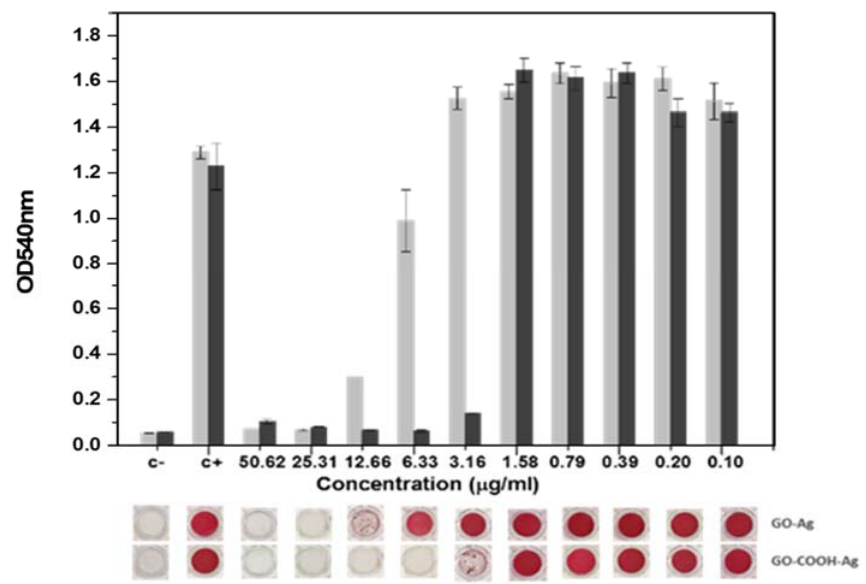
Figure 7. Effect of GO-Ag (light grey) and GOCOOH-Ag (dark grey) on the biofilm formation of S. aureus V329. Quantification (upper panel) and images (lower panel) of the biomass of a 48 h biofilm.